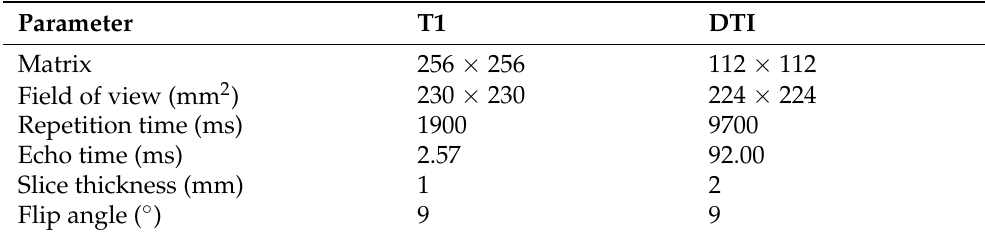
Table 2. Magnetic resonance imaging data acquisition.